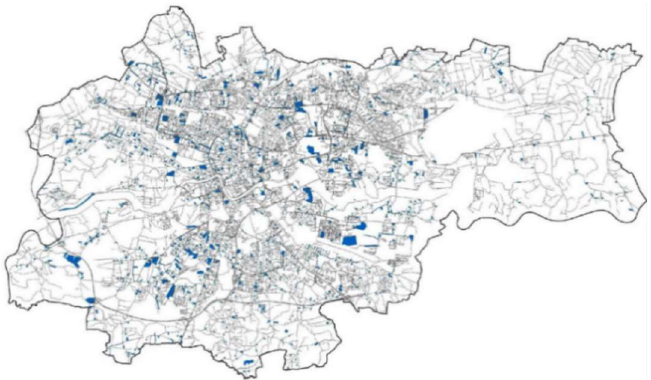
Figure 4. Map of binding location decision on building conditions as of 2003–2004. Resources: Bu-